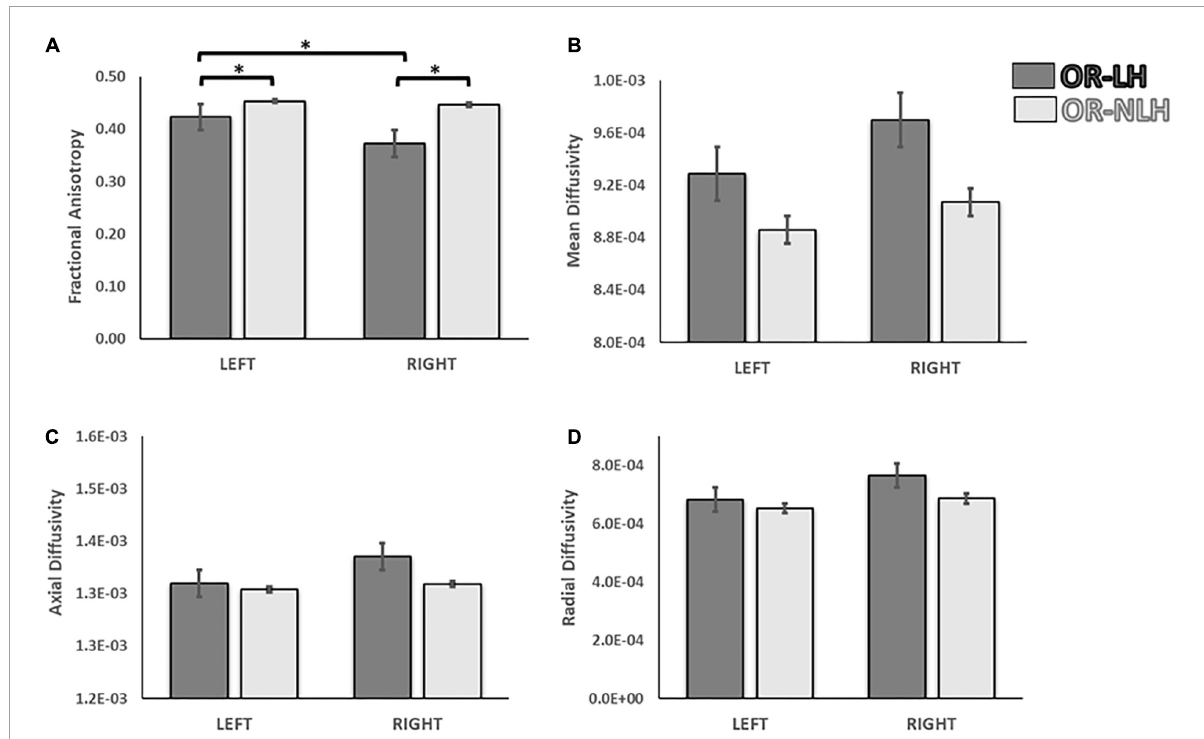
FIGURE5 Differences in white matter integrity of the OR of the lesional and non-lesional hemispheres as functions of side of lesion in children with USCP. (A) Fractional anisotropy, (B) mean diffusivity, (C) mean axial diffusivity and (D) mean radial diffusivity. OR-LH: optic radiation of the lesional hemisphere; OR-NLH: optic radiations of the non-lesional hemisphere. Error bars represent standard errors of the mean. ∗ p <